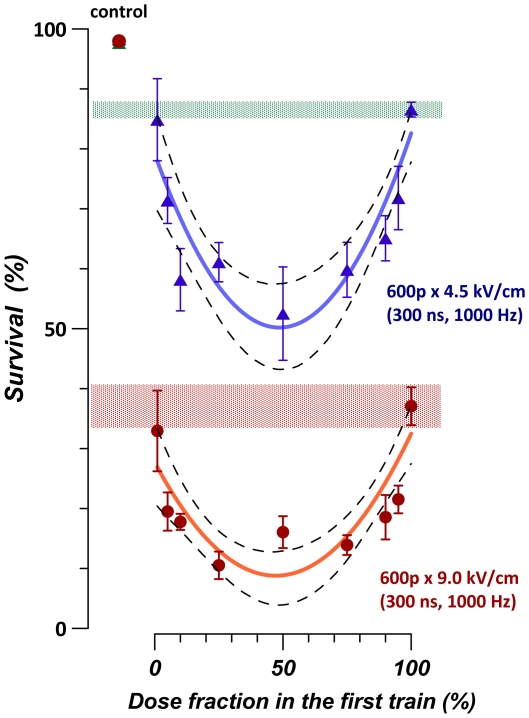
The role of fraction size in the enhancement of the EP effect by fractionation.Survival of U937 cells was determined by propidium exclusion at 4 hr following exposure to 0.3 µs EPs at either 4.5 kV/cm (top graph) or 9 kV/cm. The total number of 600 pulses was split into two fractions which were delivered with a 6-min interval. The number of pulses in the first train varied form 1% to 100% of the total. The latter value corresponded to delivering all pulses in a single train, and the respective survival levels are shown by shaded areas. Mean+/− s.e., n = 4–6. Solid lines are best fit approximations using second degree polynomial function. Dashed lines delimit the borders of 95% confidence intervals for the best fit.